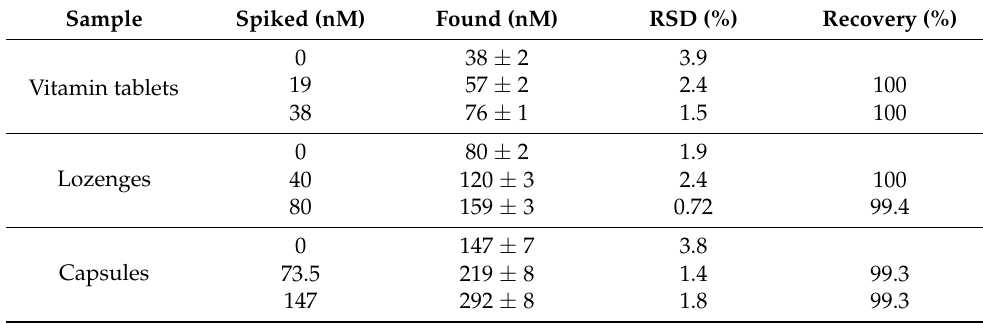
Table 5. Quantification of indigo carmine in pharmaceutical dosage forms ( n = 5; p = 0.95).